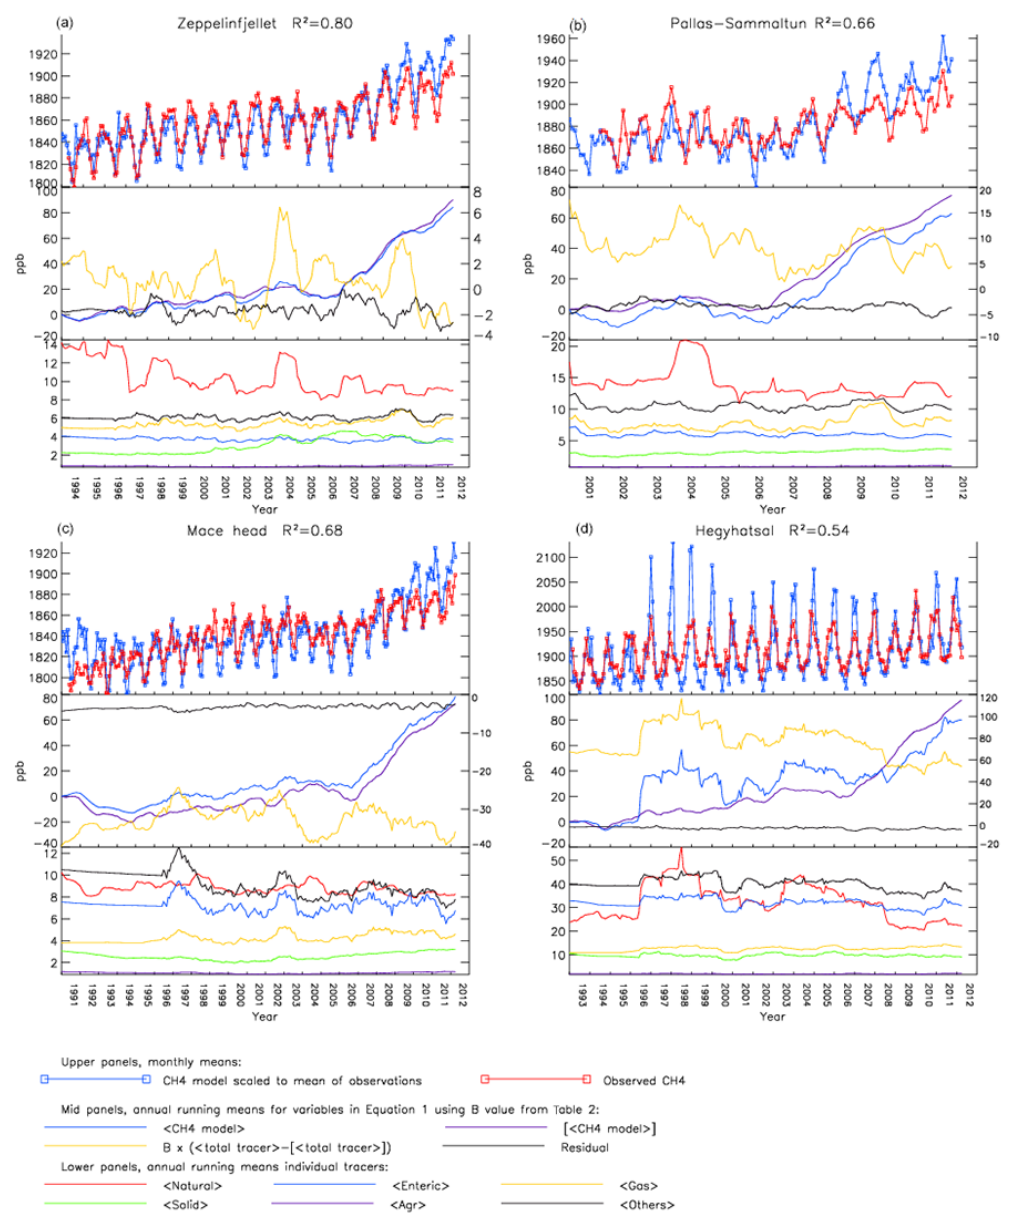
Figure 8. Evolution of CH 4 and tracers at stations ( a : Zeppelinfjellet, b : Pallas–Sammaltun, c : Mace Head, d : Hegyhatsal) in or near Europe. See Fig. 6 caption for further